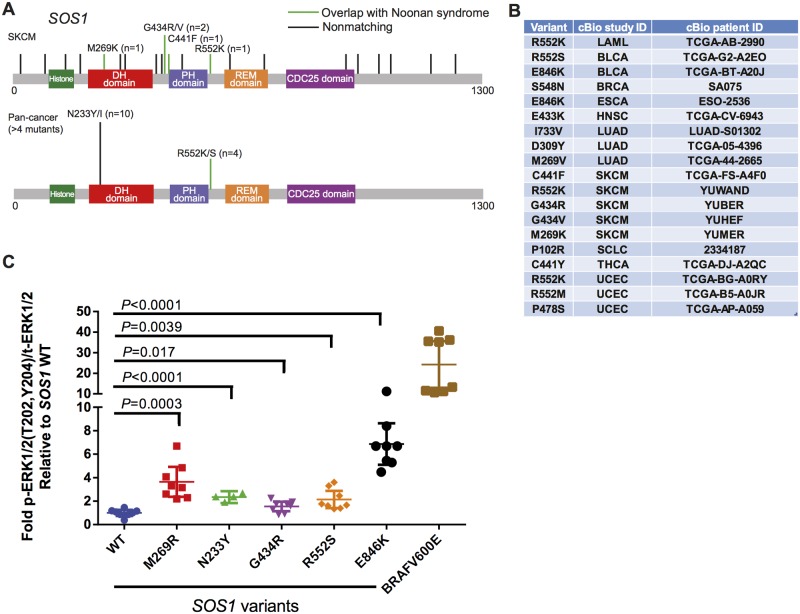
SOS1 mutations are significantly associated with cancer and activate the RAS/MAPK pathway.(A) Top: All four skin cutaneous melanoma datasets in cBioPortal are presented. Vertical lines indicate mutations in SOS1. Green lines identify overlap with Mendelian diseases. Bottom: A pan-cancer version of the SOS1 mutational data is presented. Data is filtered for N ≥ 4. (B) A table containing all SOS1 variants across the TCGA that match a known Noonan syndrome—associated residue. cBioPortal study ID refers to the indication name in the cBioPortal. The patient ID is the unique sample identifier for the given study. (C) HEK293T transfection experiment for phosphorylated ERK1/2. Dots indicate biological replicates (N = 8). P value was assessed by Student t test.